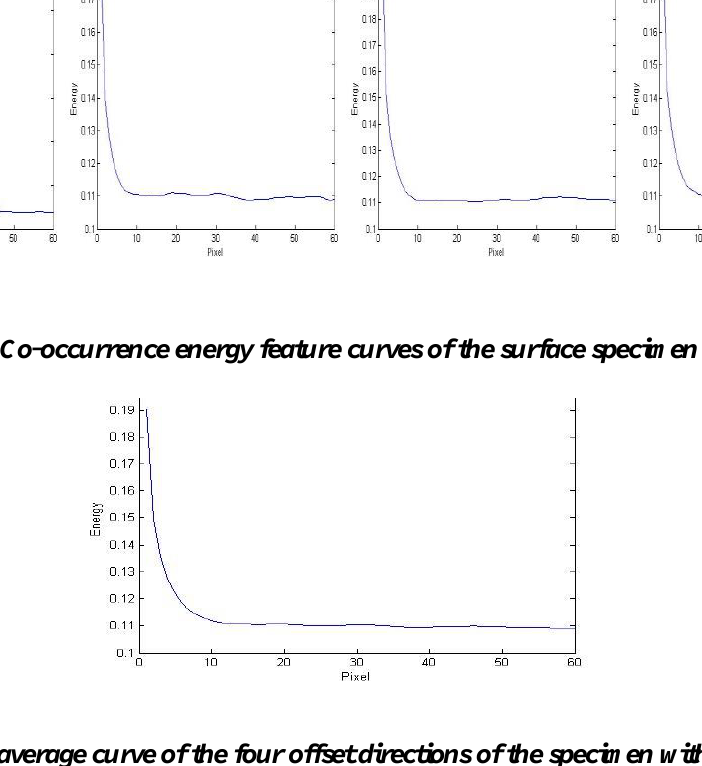
Fig.12: The average curve of the four offset directions of the specimen with R